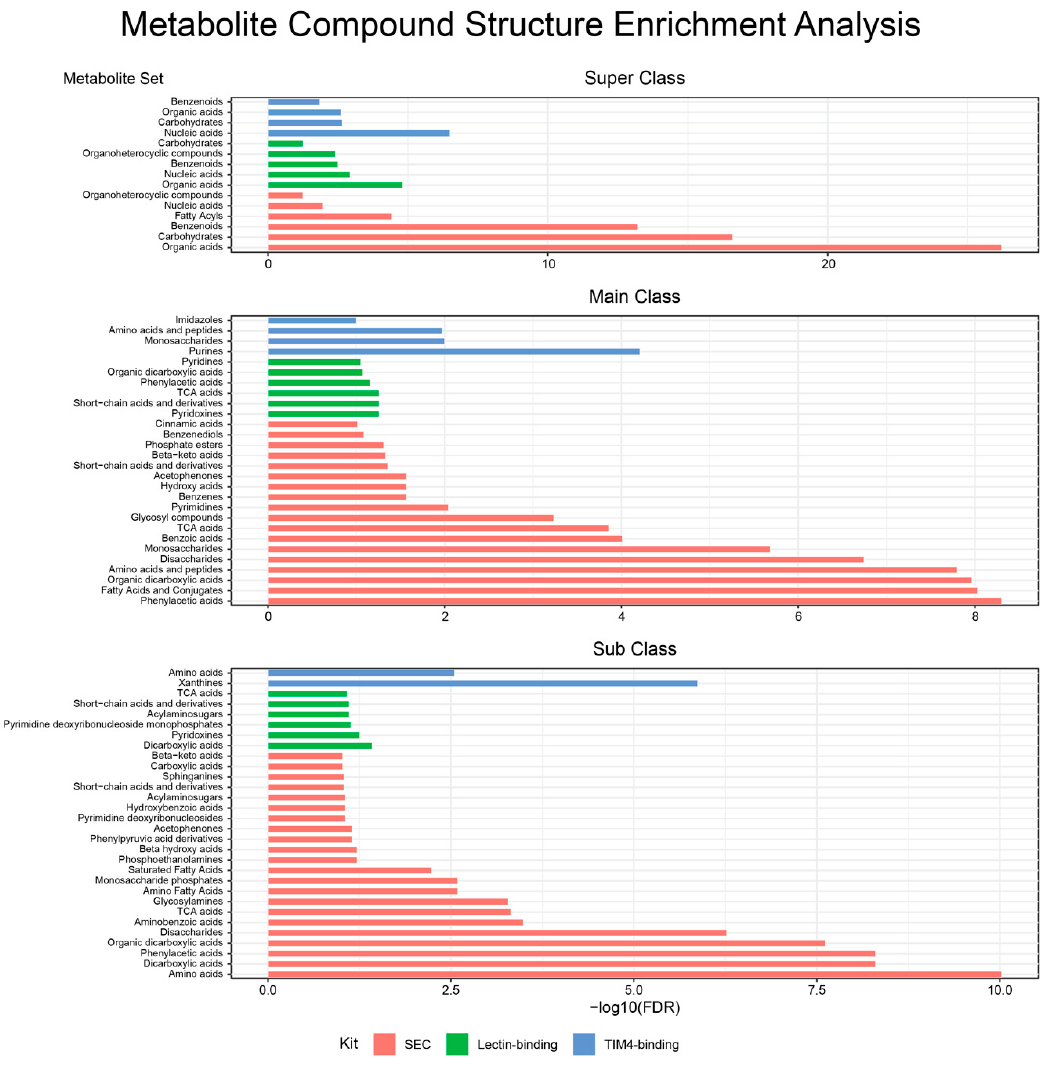
Figure 5. Enrichment results for compound classes with unique metabolites that each exosome isolation method produced. Results pass FDR < 0.1.